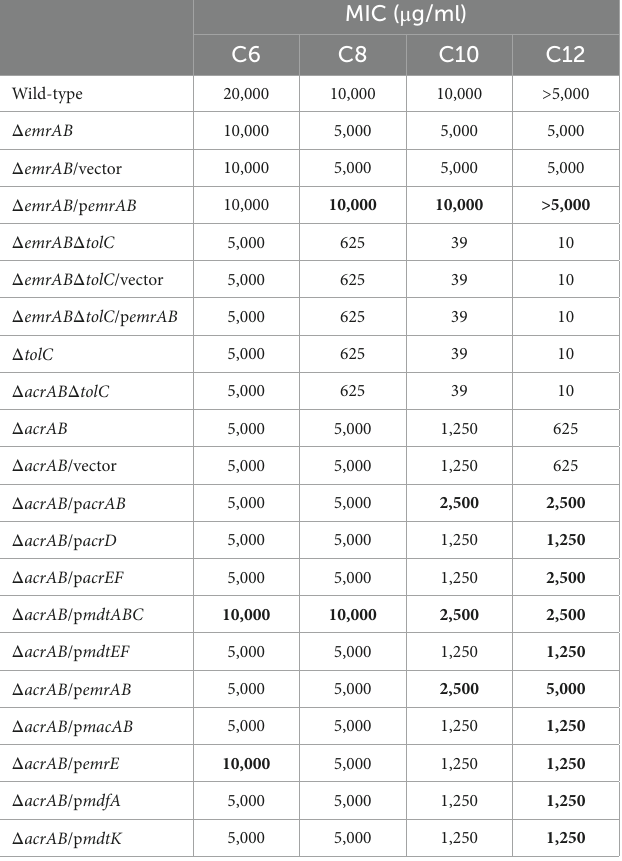
TABLE 3 Escherichia coli strain susceptibility to sodium hexanoate (C6), sodium octanoate (C8), sodium decanoate (C10), and sodium dodecanoate (C12) using minimum inhibitory concentrations (MIC).